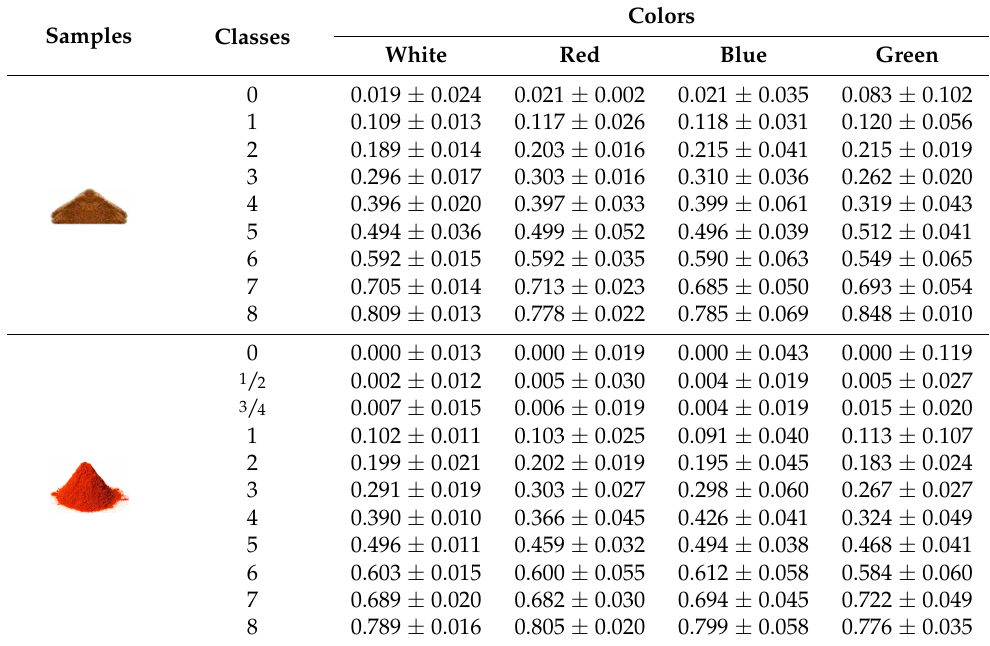
Table 5. Mean values ± standard deviation of the TSS estimated by the CNN + MLR for each color dataset for the fish feed and paprika